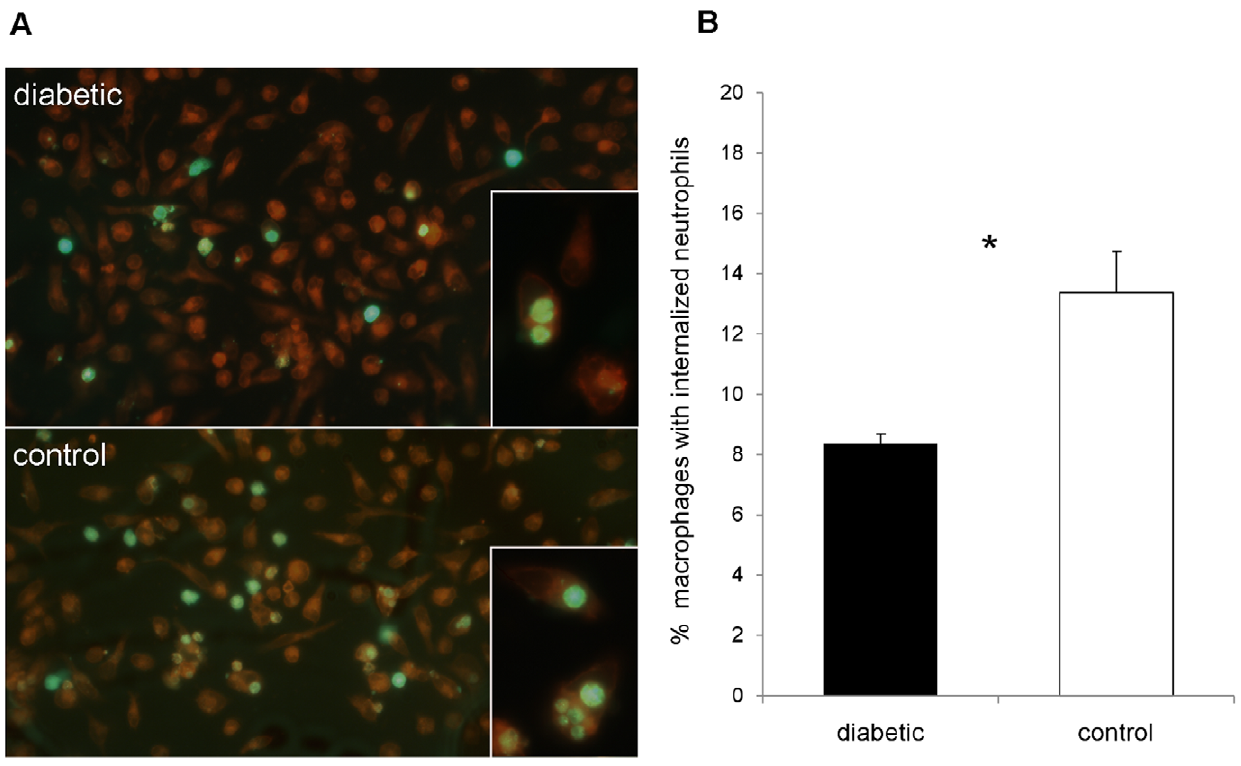
Figure 7. Invitro phagocytosis of apoptotic neutrophils by murine macrophages. Inflammatory cells were isolated from infected mouse peritoneal cavities 18 h after IP challenge with 10 8 CFU PS80. The neutrophils were labeled with CellTracker Green, incubated in vitro for 8 h to induce apoptosis, and incubated with adherent autologous macrophages for 90 min to allow for uptake. (A) Representative image of CellMask Orange-stained macrophages with phagocytosed neutrophils from an age-matched pair of a diabetic (upper picture) and nondiabetic (lower picture) control mice. Phagocytosis of apoptotic neutrophils by macrophages from diabetic mice is less than that of macrophages from nondiabetic mice. Some neutrophils are still extracellular whereas others have been internalized. (B) Macrophages from diabetic mice ingested significantly fewer neutrophils than macrophages from nondiabetic control mice. Data are means 6 SEM of six independent experiments; * indicates P , 0.05.